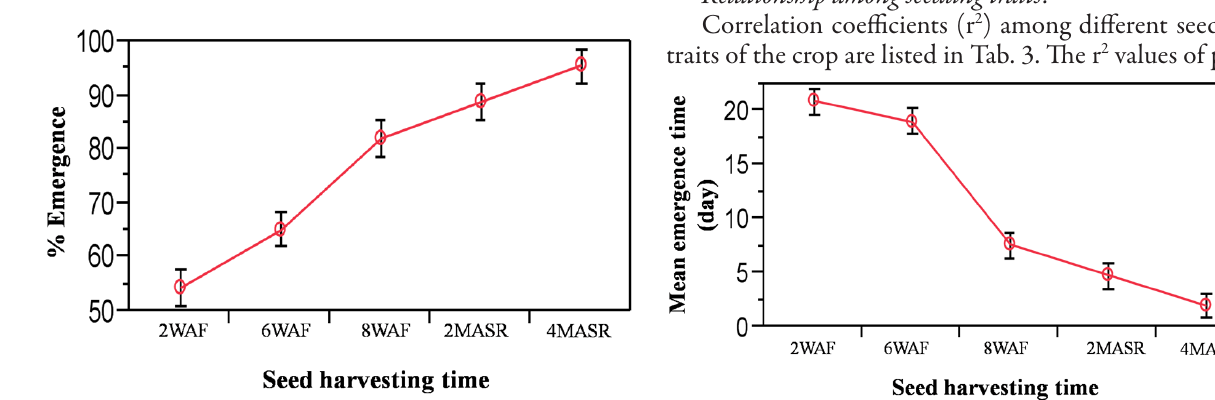
Fig. 2. Effect of different seed harvesting times on mean emer- gence time in R. turcomanicus